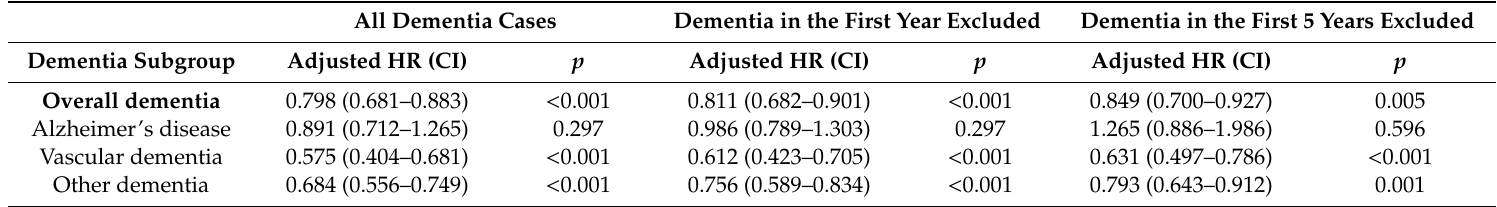
Table 2. The risk for dementia according to the use of DPP-4i.